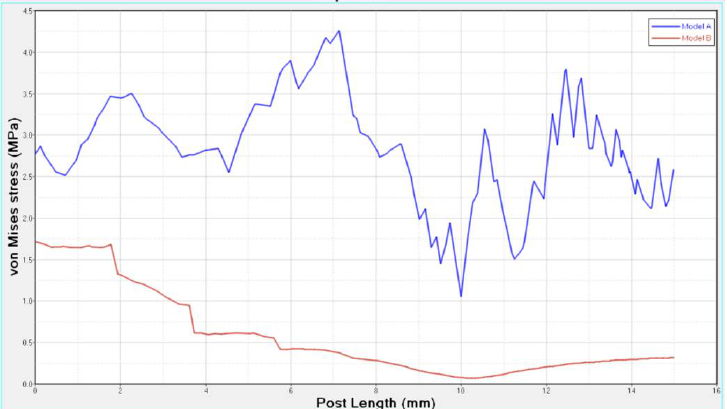
Figure 7. von Mises stress distribution along the center of the post from the coronal to the apical part.